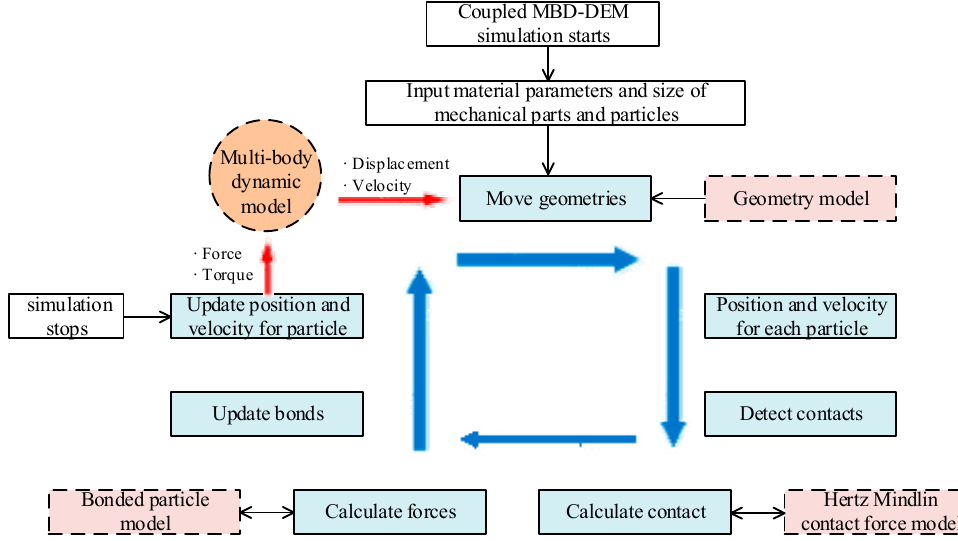
Figure 13. Numerical calculation flow chart for coupling of multibody dynamics (MBD)-discrete element method (DEM).